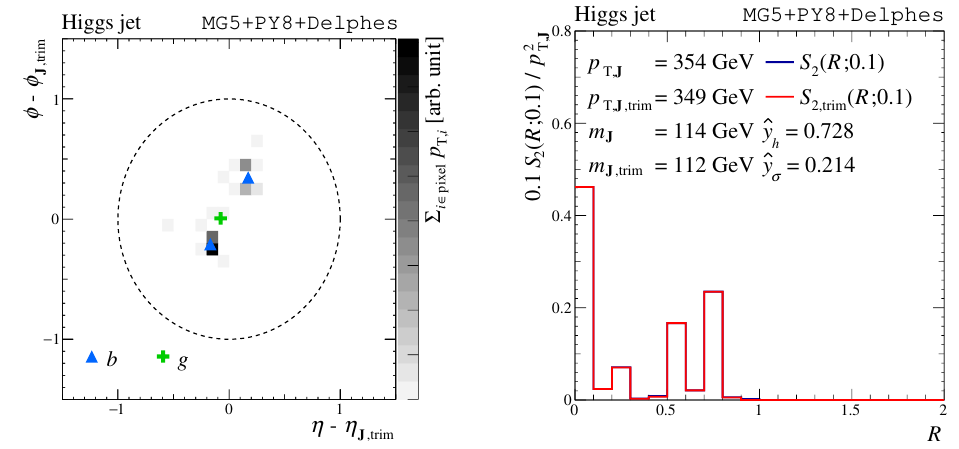
Figure 2 . A jet image (left) and the corresponding S 2 (blue) and S 2 ; trim (red) spectra (right) of the leading jet of a pp Zh event. The blue triangles in the jet image are positions of the parton ! level bottom quarks from the Higgs decay, and a green \+" shows the position of a leading gluon emitted from a bottom quark.